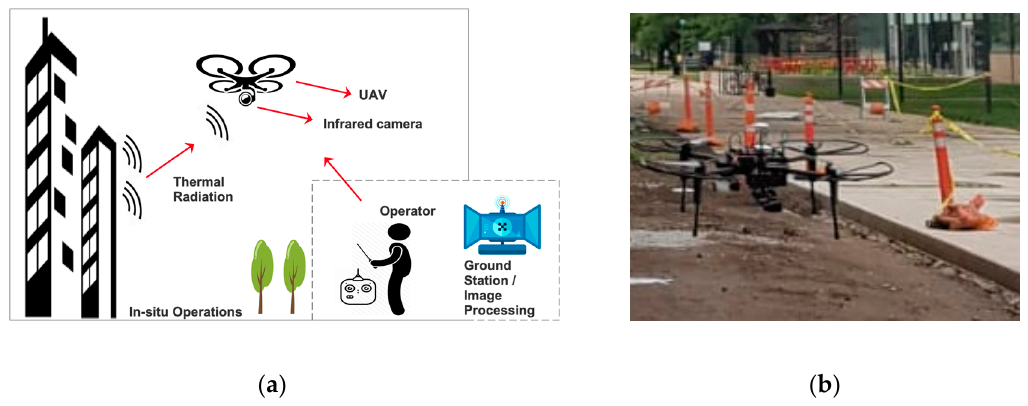
Figure 1. Data collection using IRT with UAV. ( a ) Operations with UAV and noncontact IR camera; and ( b ) UAV (DJI Matrice 100) with IR camera (Flir Vue Pro-R 640 9 mm).